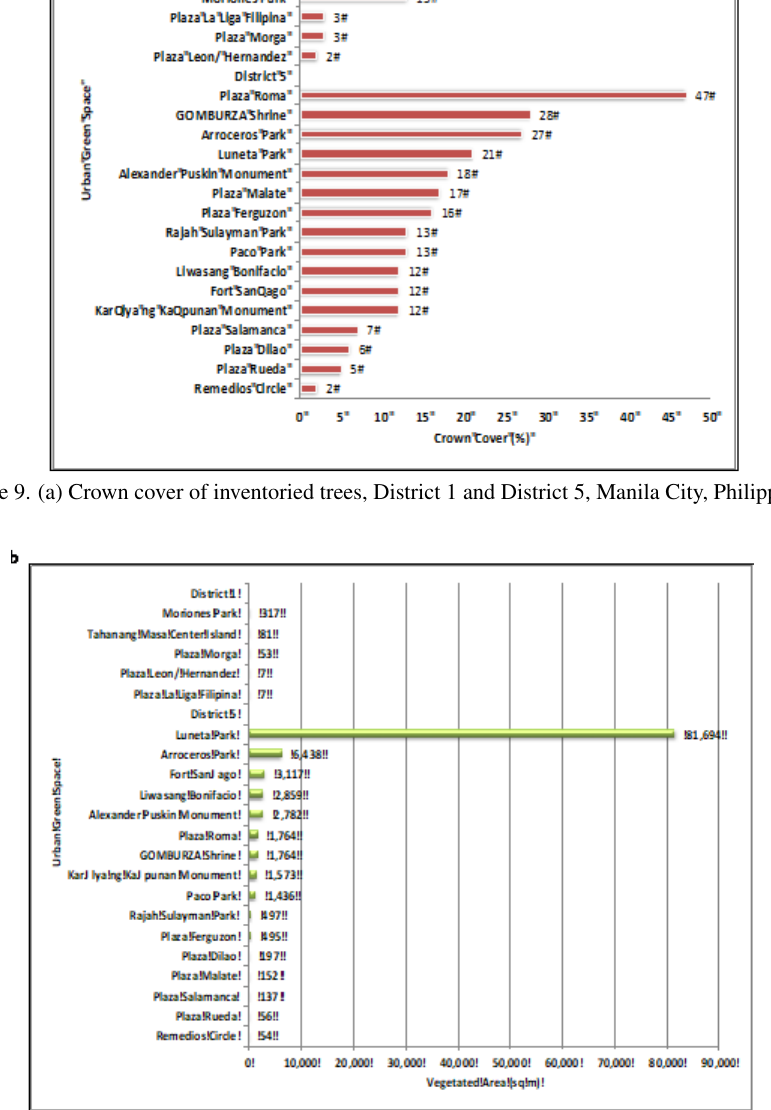
Figure 10. (b) Vegetated area of inventoried trees, Districts 1 and 5, Manila City,